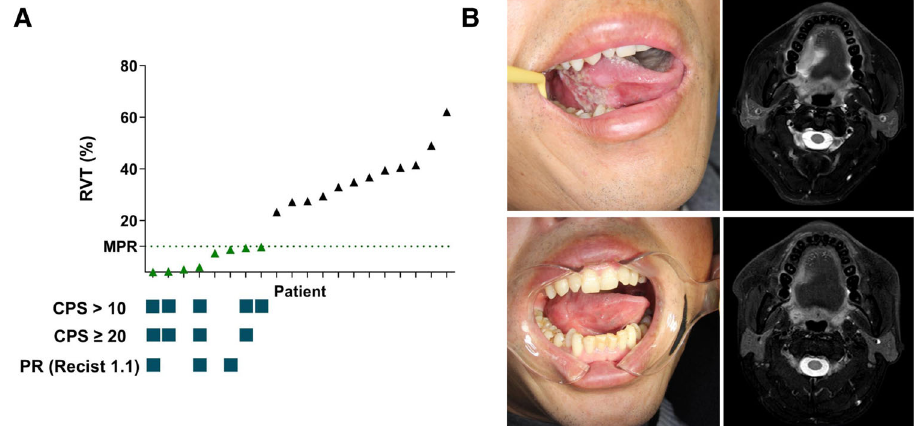
Fig.2|Ef fi cacyofneoadjuvanttherapy.A Residualviabletumourcell(RVT)ratio, combined positive score (CPS), and radiographic partial response (PR) in 20 patients. The percentage of RVT was evaluated on resected tumour slides after surgery.TheCPSwasde fi nedasthetotalnumberofprogrammedcelldeath-ligand 1-stained cells (including tumour cells, tumour-associated lymphocytes, and mac- rophages) divided by the total number of viable tumour cells plus 100.